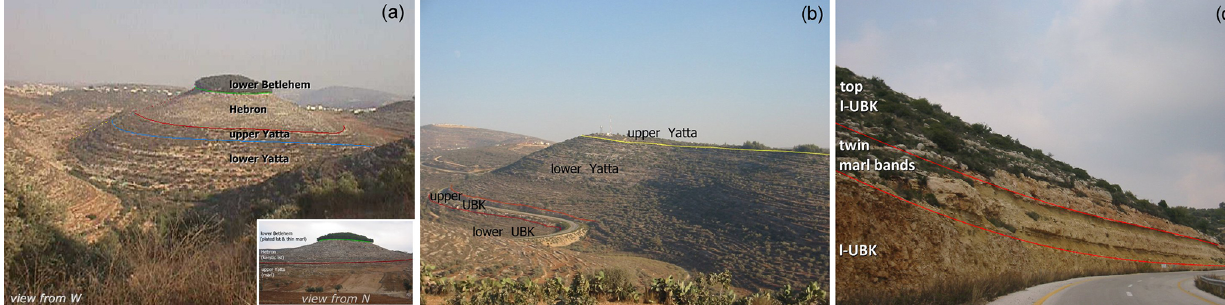
Figure 3. Correlation of landform and lithology. Nabi Ghayth hill, west of Beitillu (a) , and Nabi Aneer spring group (b) . Twin marl band underlying a local perched aquifer (c) . Note that the karstic limestone of Hebron formation forms outcrops with thin soil cover, bare rock or karren fields and tends to erode into steeper slopes above the soft, mostly eroded upper Yatta formation – the only true aquiclude within the West Bank Group (with levelled agricultural plains in the inlet photo in (a) . By contrast, the top of the hill is formed by lower Bethlehem formation, a thinly plated coloured limestone ensemble with fine marl interbedding that lacks karstification and promotes soil development and natural vegetation. Panel (c) shows the twin marl band, underlying and confining Beitillu, Harat Al-Wad spring group (of top l-UBK formation).